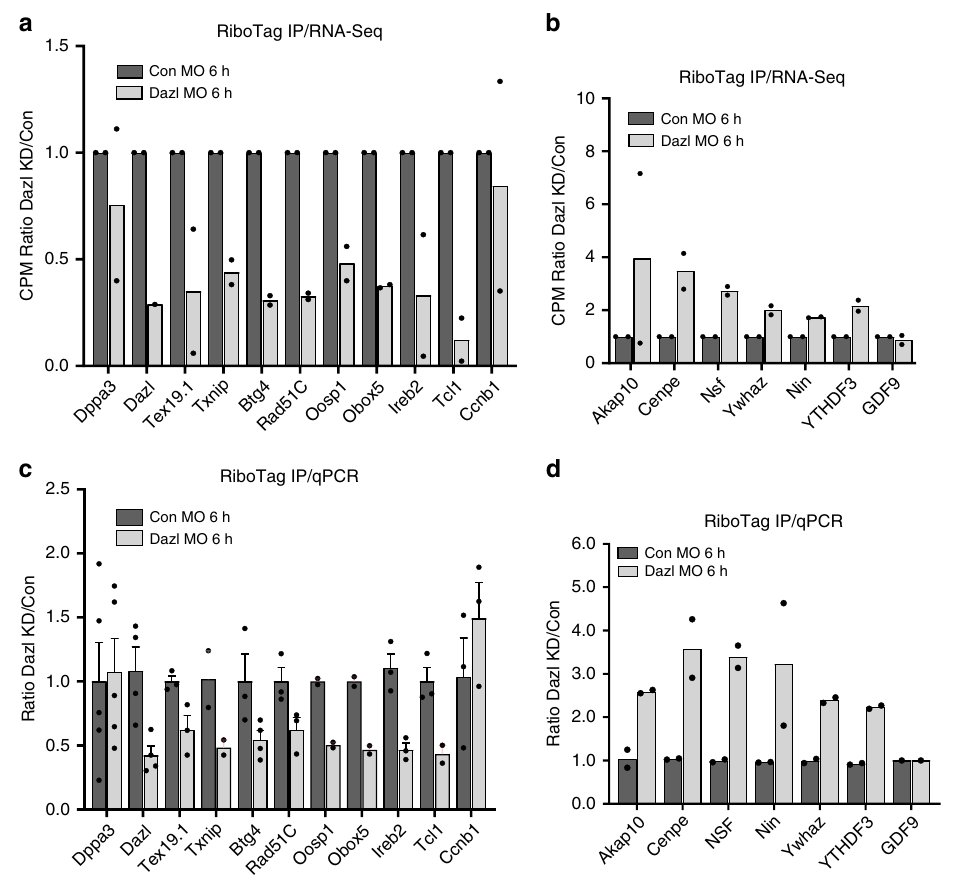
Fig. 3 RiboTag IP/qPCR con fi rms the presences of a subset of transcripts whose translation is upregulated and downregulated in oocytes depleted of DAZL. Representative mRNA targets affected by DAZL removal. RiboTag/RNA-Seq data are reported in a down and b up. Ribosome loading DAZL-MO/CON- MO for the same transcripts assessed in independent biological replicates by RiboTag IP/qPCR is reported in c , down and d up. Data are reported as ratio DAZL KD/control. Dppa3 and CcnB1 are used as negative control in a , c . Gdf9 mRNA is used as negative control in b , d . Experimental conditions are identical to those described in Fig. 2b except for the qPCR analysis. Bars are the average of two or more observations. P values in panel C were calculated with the Bonferroni- Dunn method, with alpha = 0.05. Each gene was analyzed individually, without assuming a consistent SD. P values are the following: Dppa3 = 0.851918, Dazl